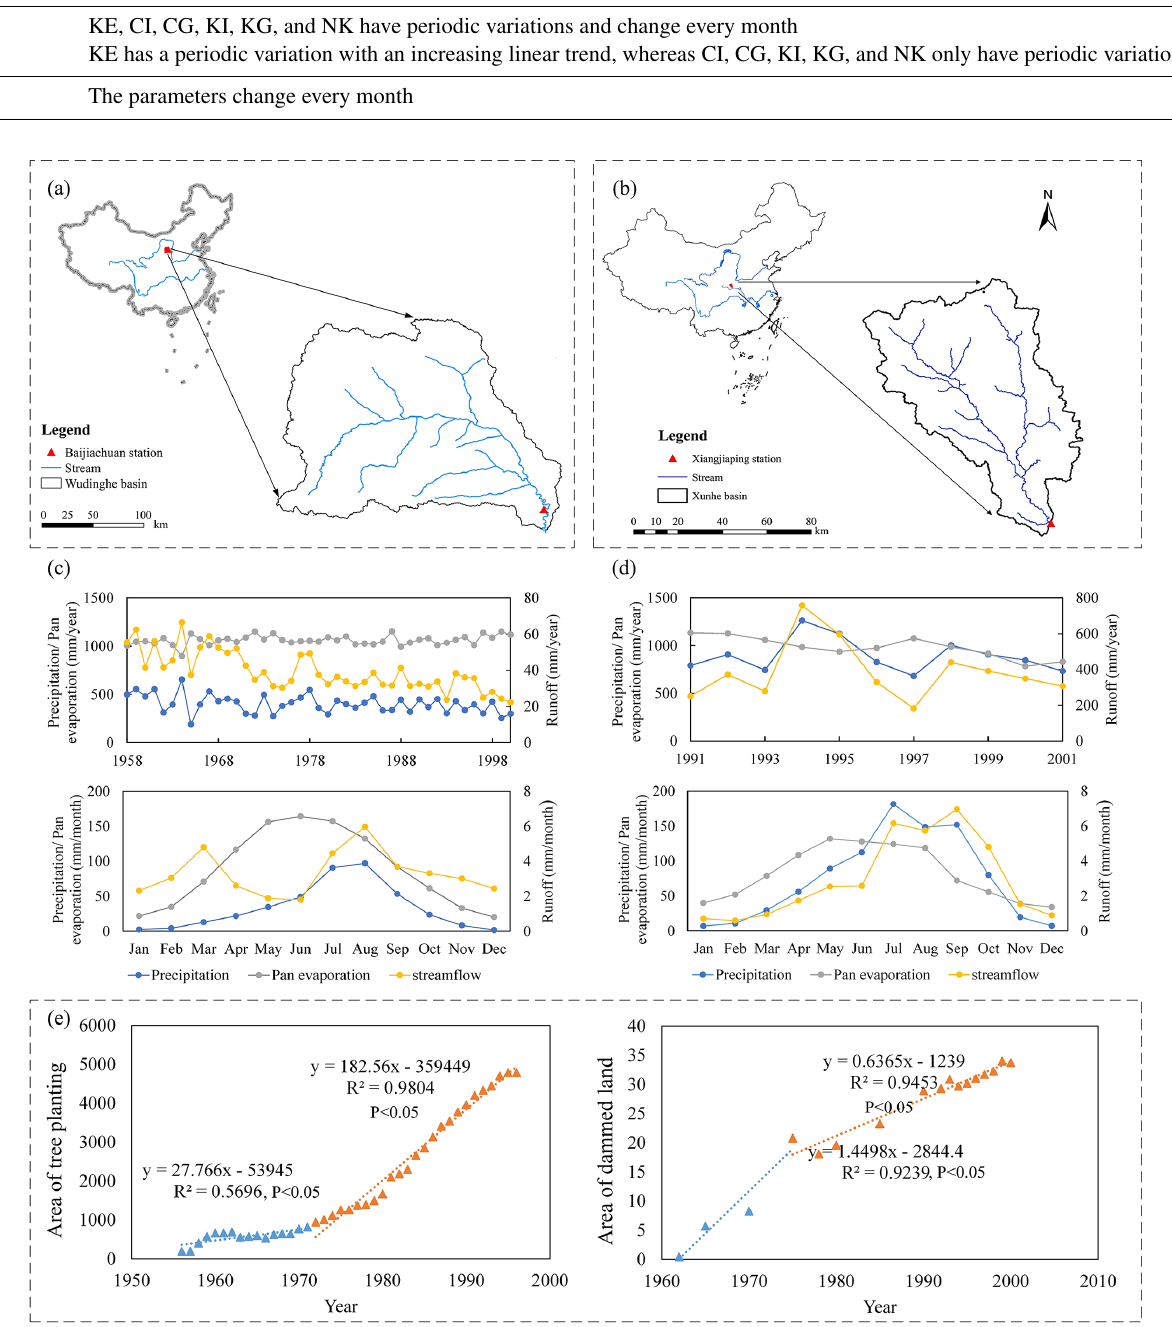
Table 5. True parameters of different scenarios in the synthetic experiment with the Xinanjiang model Scenario Description 1 KE, CI, CG, KI, KG, and NK remain constant KE, CI, CG, KI, KG, and NK have linear trends and change every month KE, CI, CG, KI, KG, and NK have periodic variations and change every month